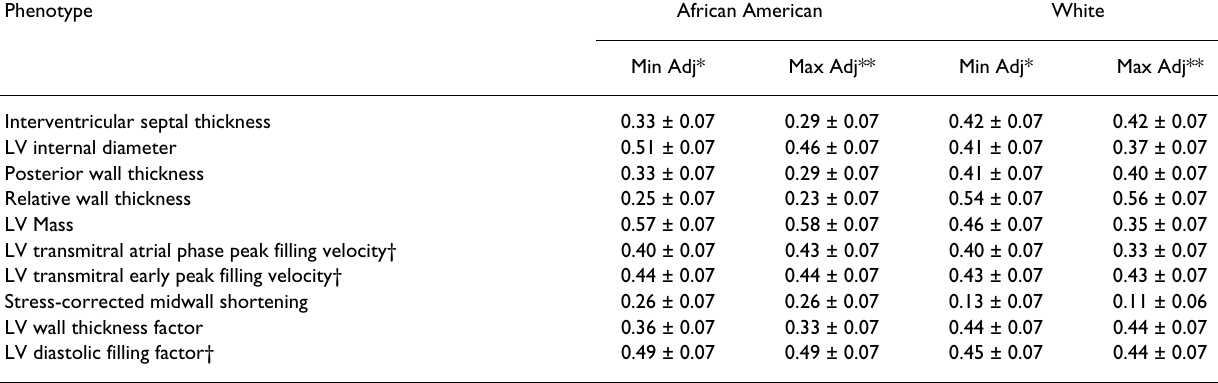
Table 4: Estimates of Heritability ± SE for LV Structure and Function Phenotypes in African American and White Families